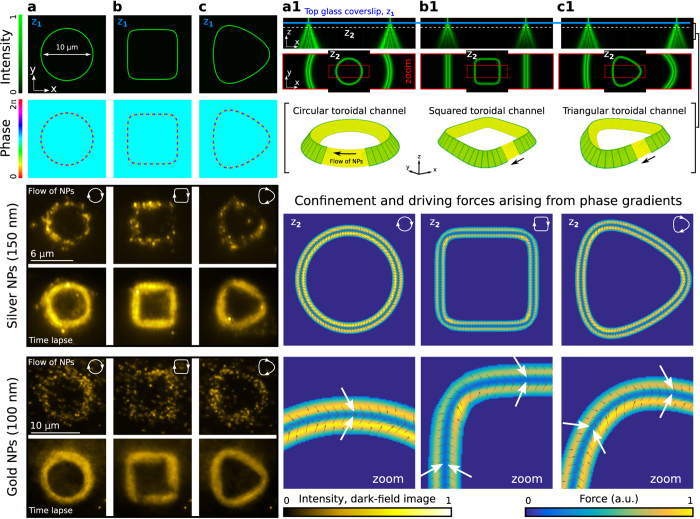
Top panel shows the intensity and phase of the laser trap focused (plane z1) into a circle (a), square (b) and triangle (c). Focusing profiles in the XZ plane for each case are shown in (a1), (b1) and (c1), correspondingly. A zoom inset of the intensity distribution at the plane z2 is displayed for each case in (a1), (b1) and (c1), for illustrating the shape of the toroidal channel. The corresponding distribution (vector field and modulus) of the confinement and driving forces () are displayed in the bottom panel of (a1), (b1) and (c1). A rotating flow of NPs confined within the toroidal channel is shown for each trap shape in the bottom panel in (a–c). Time lapse images of the flow are also displayed. In the case of the circle the considered values of topological charge are l = 15 (with radius 3 μm) for silver NPs and l = 30 (with radius 5 μm) for gold NPs. These values of charge l have also been applied for the square and triangle, correspondingly. The flow of NPs rotates clockwise for l > 0 and anticlockwise for l < 0, see Supplementary video 1 and 2.